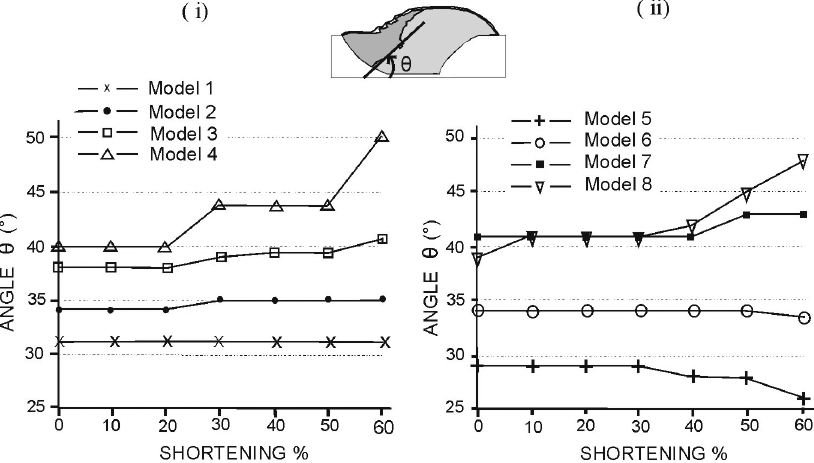
Fig. 5 – (i-iv) Line drawings of cross-sections cut through the central region of models 1 to 4: end results. E1-E3 are normal faults that were formed during extensional steps; F1-F3 are forethrusts, and B1 and B2, backthrusts. Dashed and continuous lines represent extensional and compressive structures, respectively.